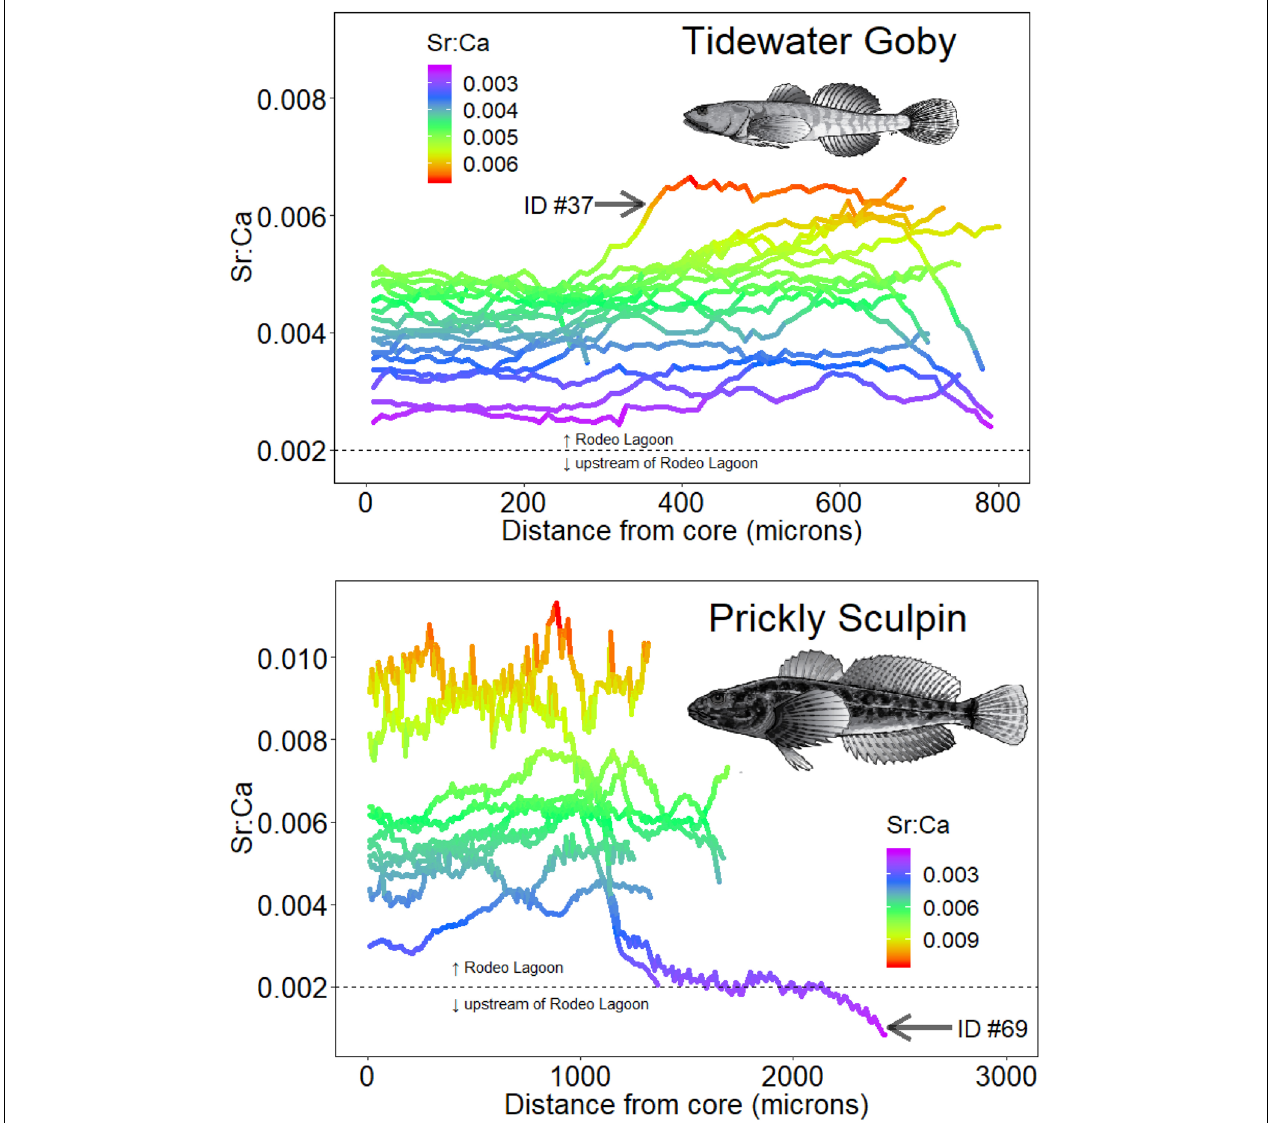
FIGURE 4 | Otolith Sr:Ca chronologies of Tidewater Gobies (upper panel) and Prickly Sculpins (lower panel) . The horizontal dashed lines show the Sr:Ca value distinguishing Rodeo Lagoon from upstream habitats. For illustrative purposes, otoliths of the noted individuals are shown in Figure 2 . The two Prickly Sculpin with ending Sr:Ca values at or below 0.002 were the individuals that were collected from Rodeo Creek upstream of Rodeo